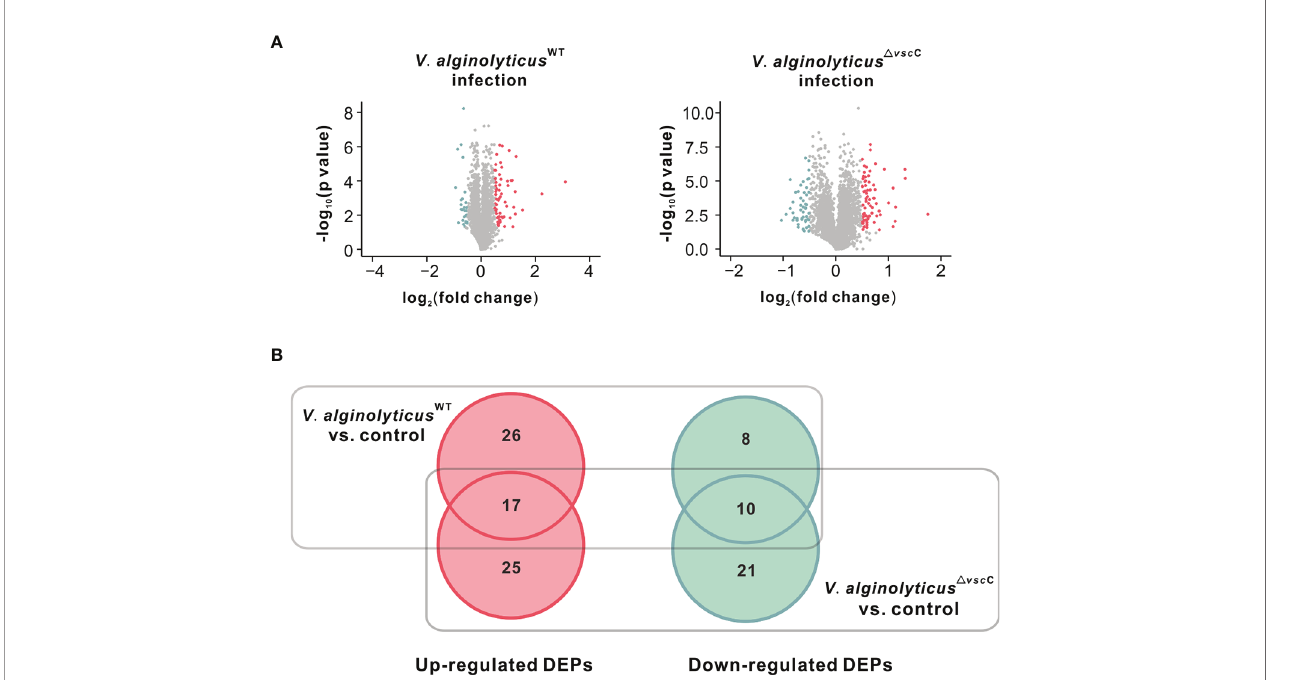
FIGURE 2 | Differentially expressed proteins after injection of the V. alginolyticus WT strain or V. alginolyticus △ vscC strain. (A) Volcano plots show the relationship between fold-changes and signi fi cance for the V. alginolyticus WT (left panel) and V. alginolyticus △ vscC (right panel) challenged groups, compared with the uninfected control. The y -axis shows the -log 10 ( p -values), and the x -axis shows the difference in expression as measured in log 2 (fold change). (B) Venn diagram representation of differentially expressed proteins (DEPs) following Vibrio injection. The numbers of speci fi c and common DEPs for injection of the two Vibrio strains are as indicated. Upregulated DEPs are marked in red circles, and downregulated DEPs in green